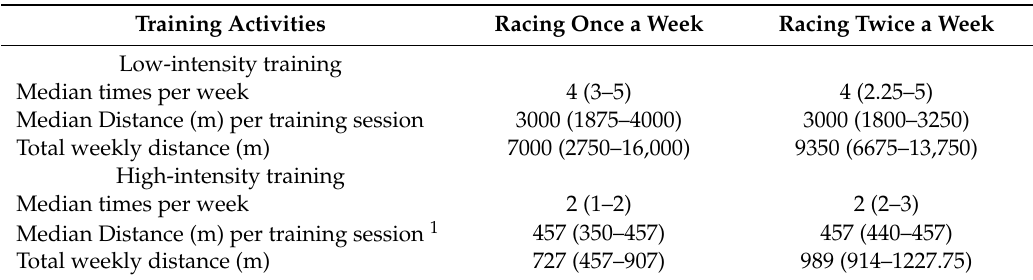
Table 2. Frequency and distance of training activities (excluding racing) of racing greyhounds as reported by 48 trainers from a cross-sectional survey of the training practices of racing greyhounds in New